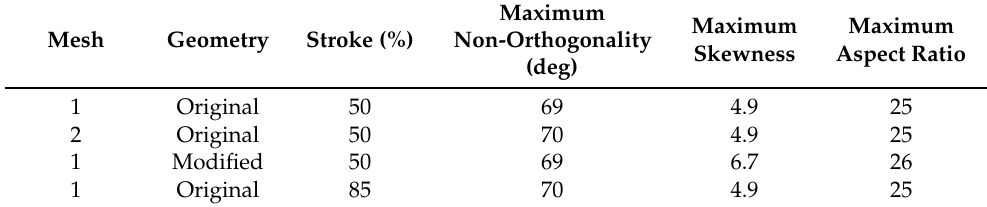
Table 2. Values of some mesh quality